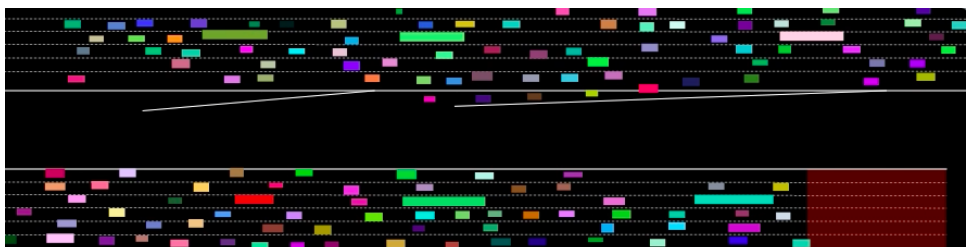
Figure 3. Sample frame reproducing the traffic of the dataset [29]. Each colored box represents a car. Dotted lines are lane separators, while solid lines are guardrails. The two segments projecting out from the first level of the road are the boundaries of the on-ramp. The second level of road is the continuation of the top one, while the red shaded rectangle is the range for the trajectory